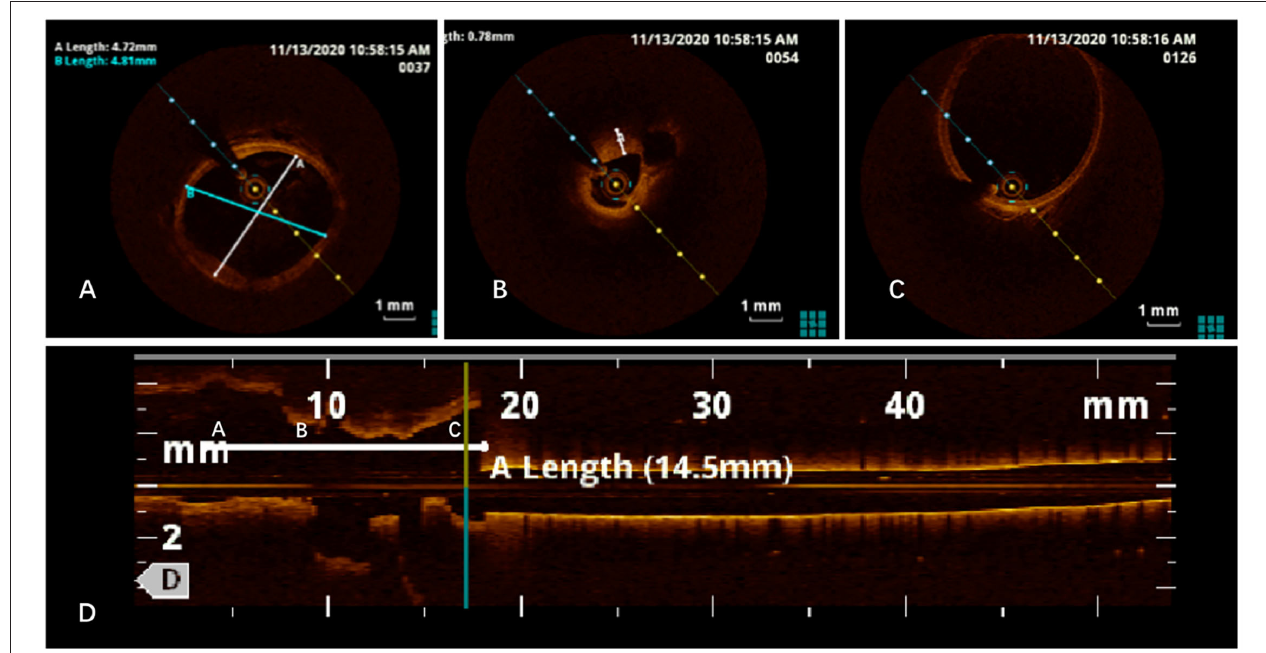
FIGURE 3 | Optical coherence tomography (OCT) imaging revealed normal intimal (A) , intimal hyperplasia (B) , post-stenotic dilatation (C) , and wavy endoluminal surface in the longitudinal reconstruction (D)